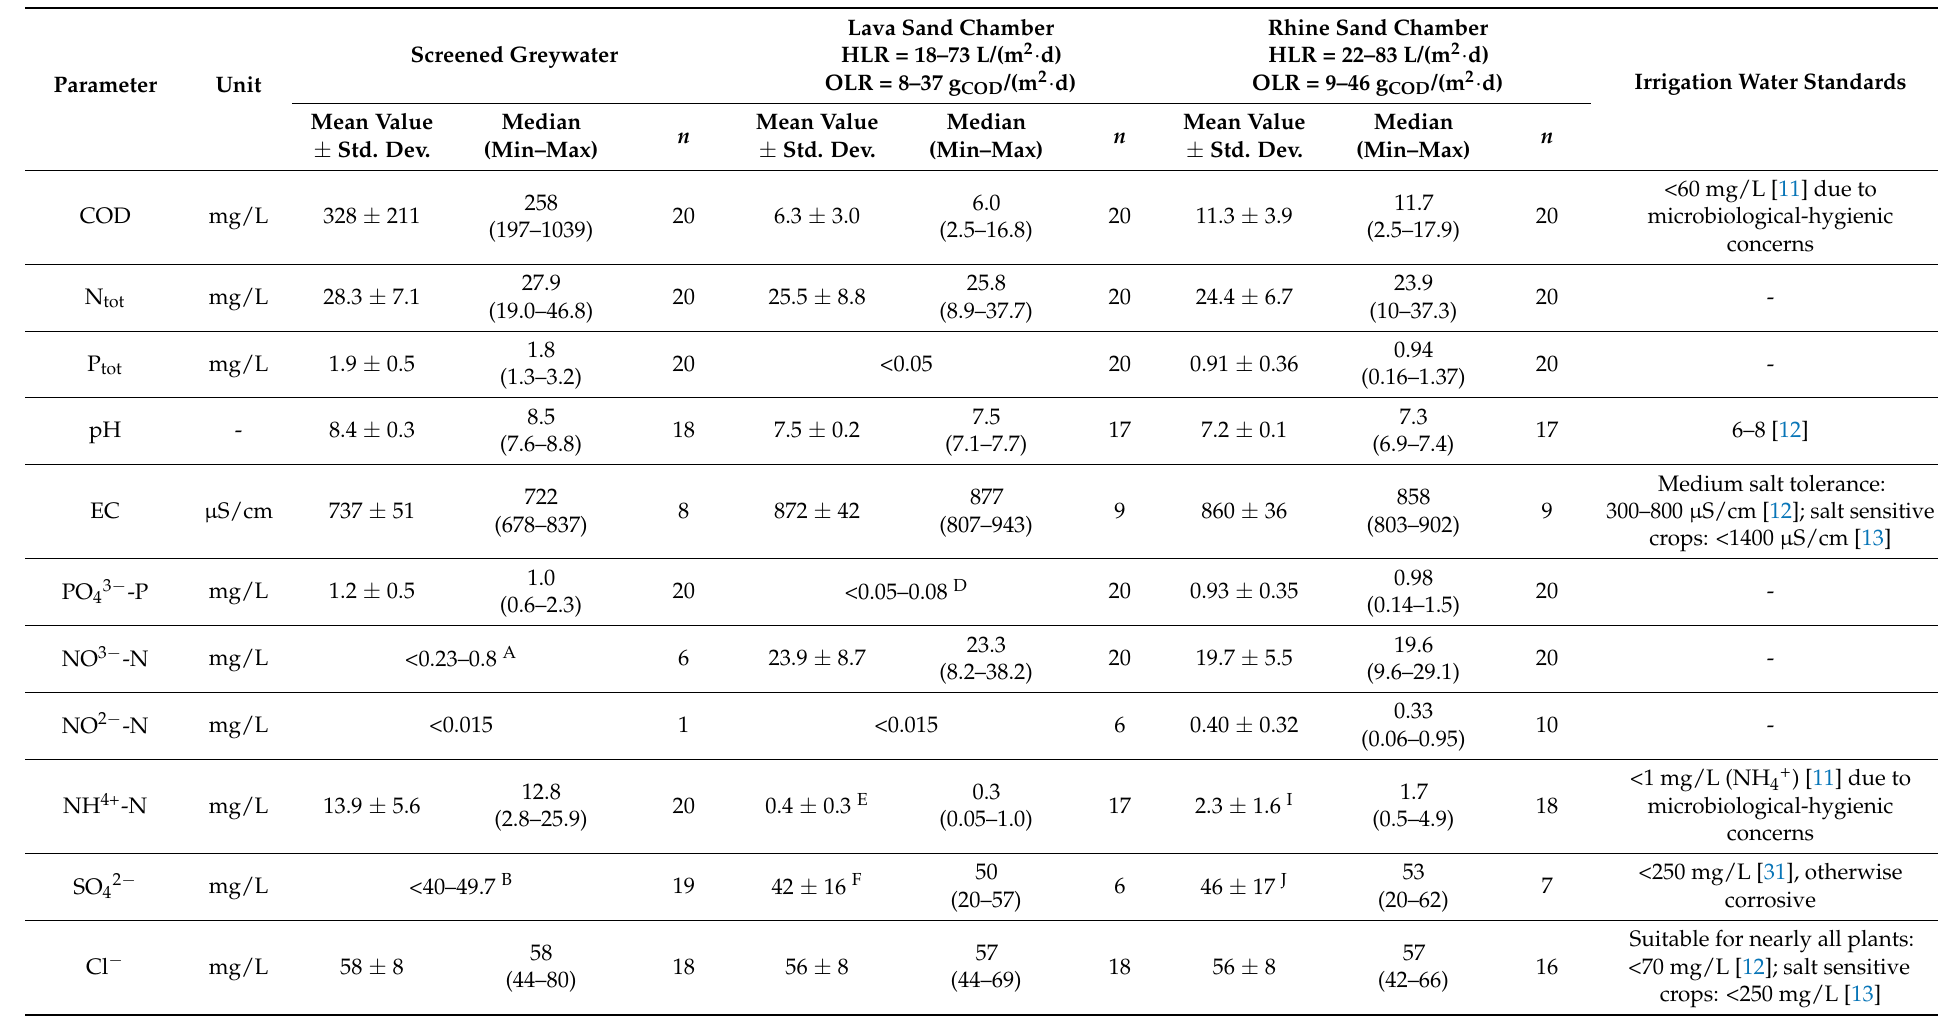
Table 3. General overview of influent and effluent values achieved by the lava sand (0–4 mm) and Rhine sand (0–2 mm) filters treating screened light greywater from shared showers and hand wash basins at temporary construction workers’ housing in Stuttgart North, in comparison with standards for irrigation